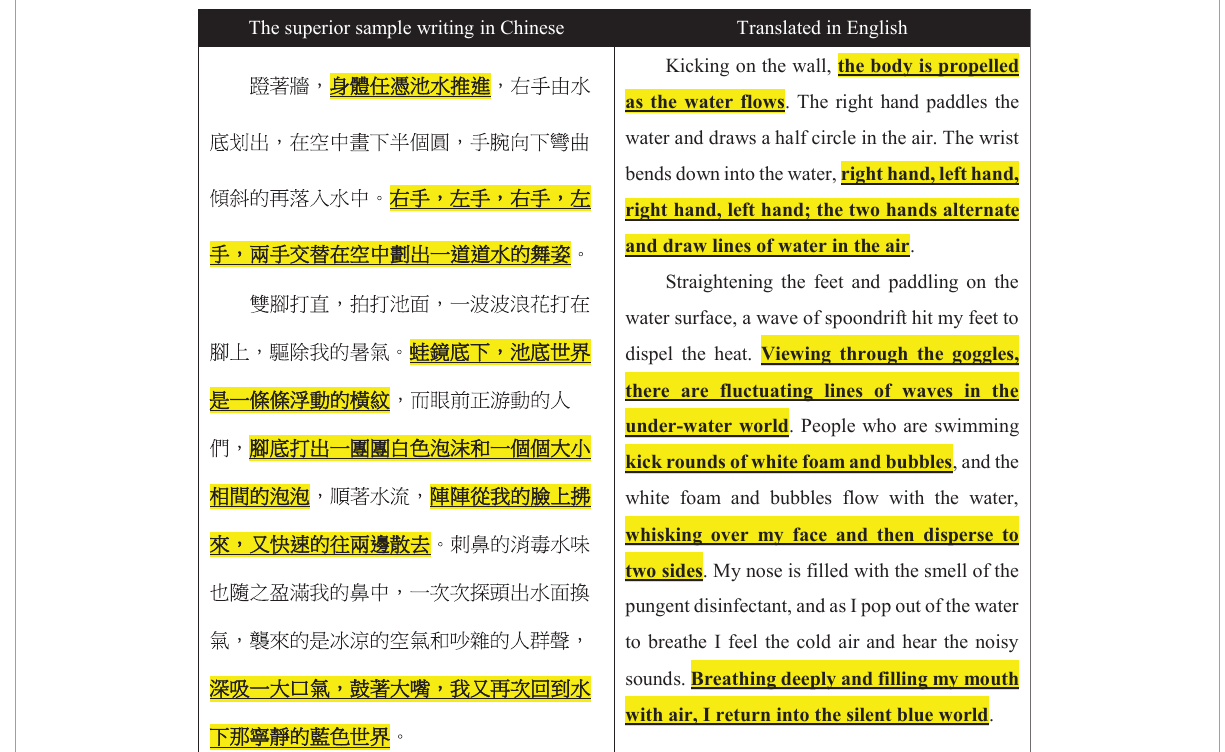
FIGURE1 Example of a student’s critique in the upward comparison